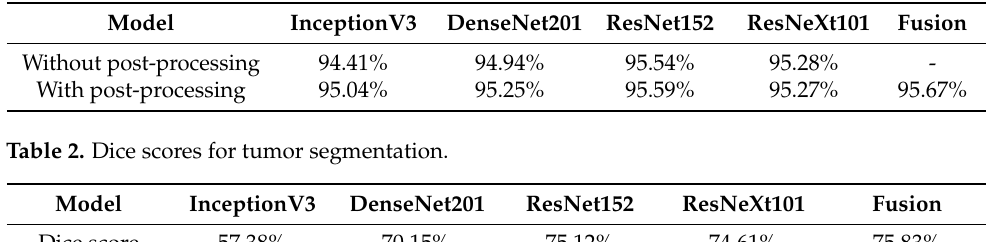
Figure 9. Dice similarity between segmentation errors for liver tissue. Table 1. Dice scores for liver segmentation.